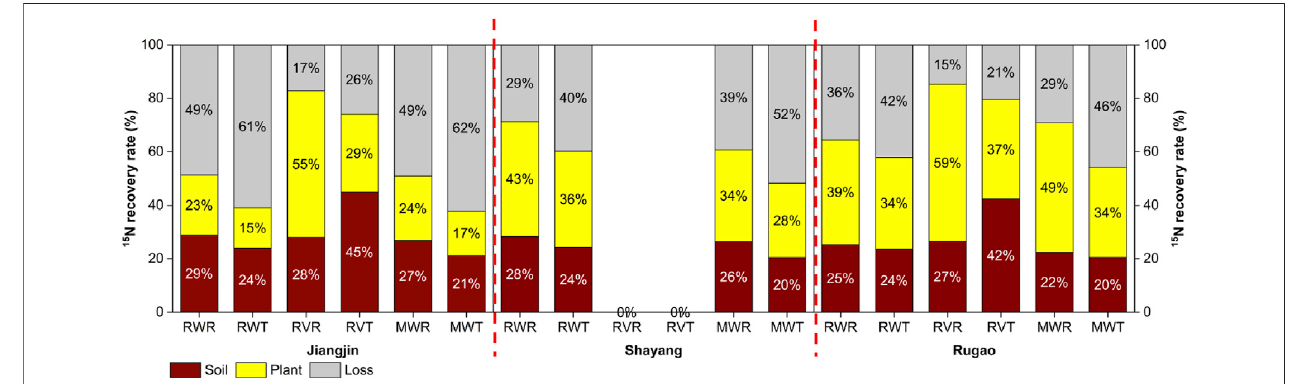
FIGURE 5 | 15 N recoveries in the crops at the end of the rotations, soil, and losses. Note: RW = rice – wheat rotation. RV = rice – vegetable rotation. MW = maize – wheat rotation. RWR = reduced fertilizer input in RW rotation, RWT = traditional fertilizer input in RW rotation, the same as RV and MW rotations in Jiangjin, Shayang, and